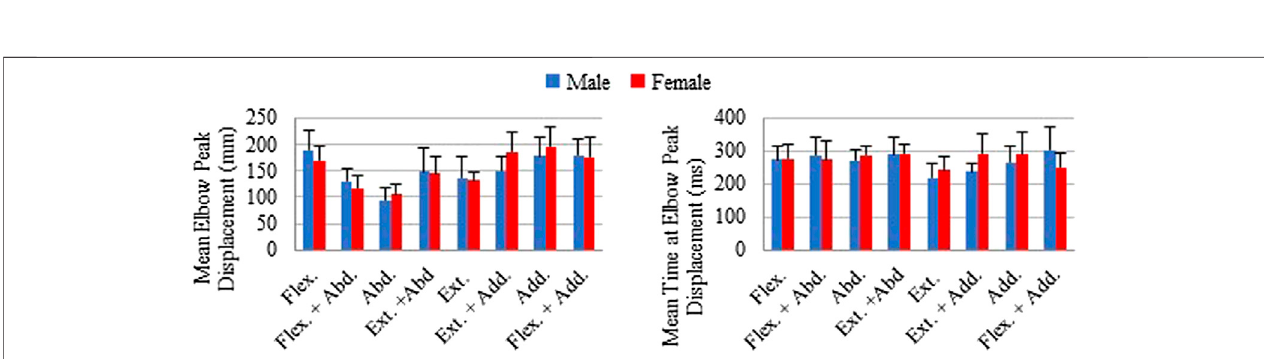
FIGURE 6 | Mean of individual peak elbow point displacements and time to peak displacements shown with plus 1 standard deviation for each loading direction. Male and female averages reported separately.